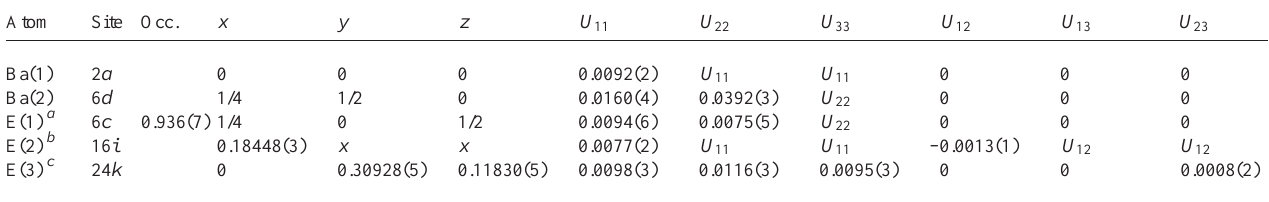
Table 6. Atomic coordinates and displacement parameters (in Å 2 )